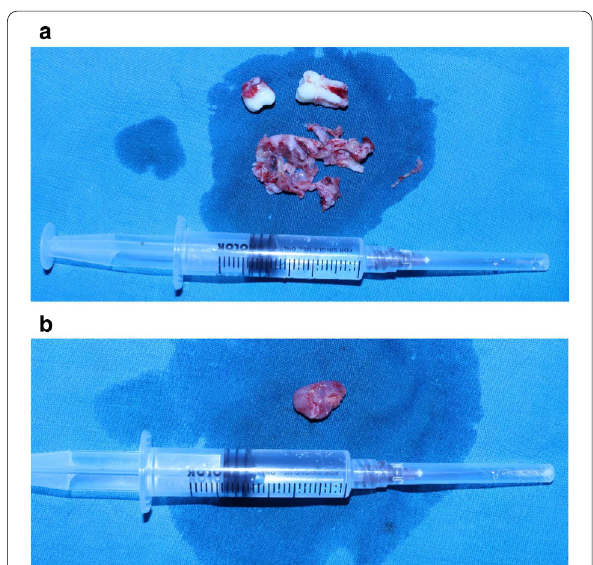
Fig. 5 a The abnormal fibrous soft tissue, mandibular right second molar, incompletely formed mandibular right third molars that were attached to the abnormal fibrous tissue. b The enlarged right submandibular lymph node was also sent for